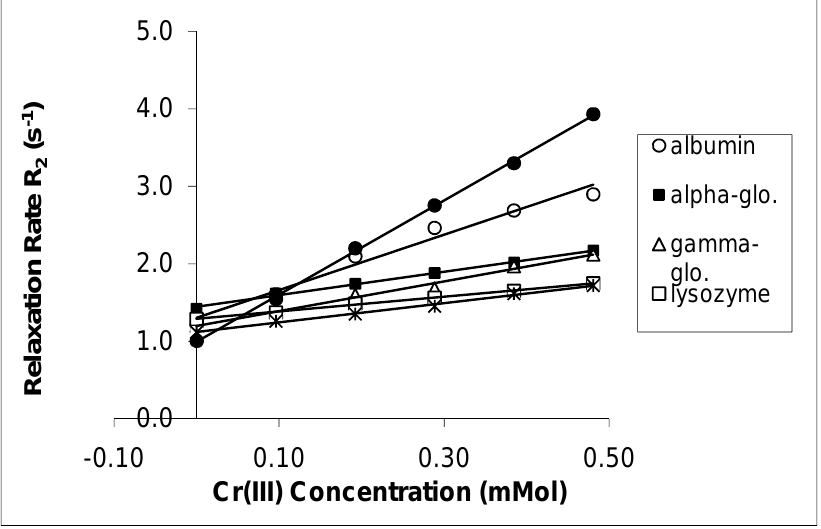
) of protein solutions versus concentration of 2